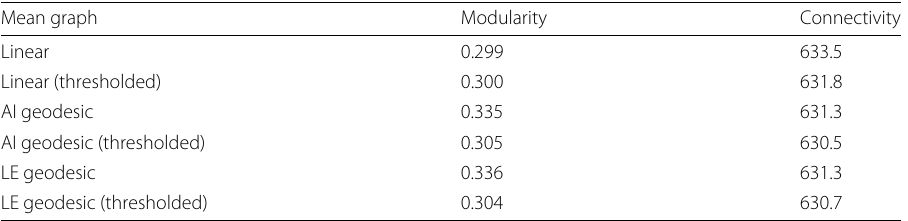
Table 1 Mean graph characteristics, synthetic graphs